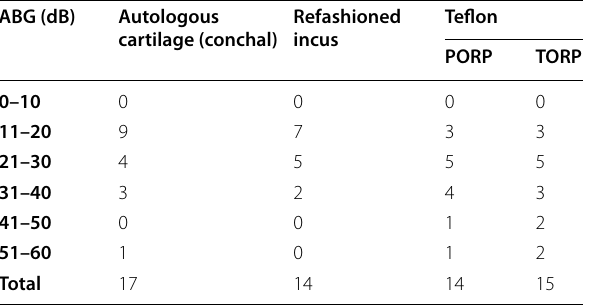
Table 3 Postoperative air–bone gap (ABG) at 6 months with different ossiculoplasty materials ( n